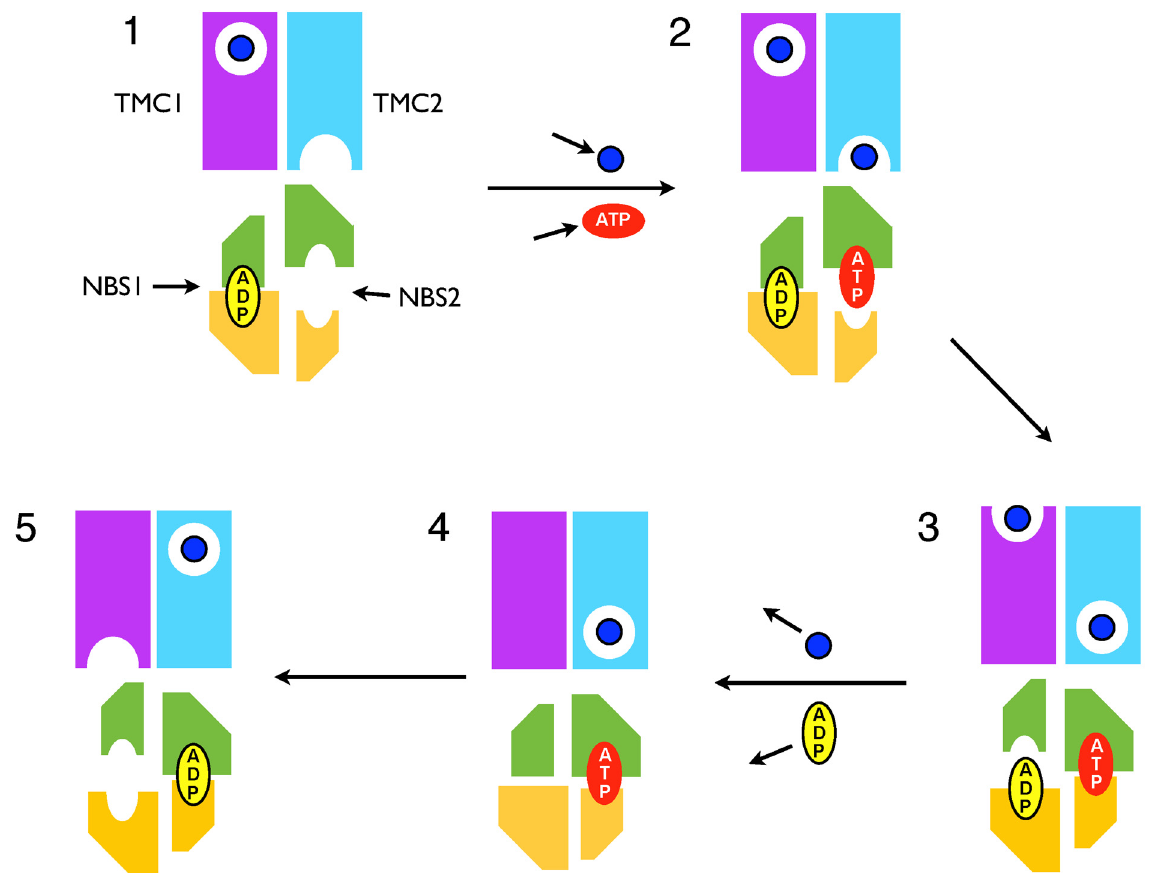
Figure 4. Reciprocating Model for an ABC Exporter. The translocation cycle of the full transporter involves two separate coupled ATP hydrolysis and substrate translocation cycles, which function 180 degrees out of phase (the cycle of a single TMC/NBS pair is depicted in Figure 3). One half cycle is shown in this figure. The TMD channels are depicted as magenta or cyan rectangles and referred to as TMCs 1 and 2, respectively. NBDs 1 and 2 are colored yellow and green, respectively. The substrate is depicted as a blue dot, ATP as a red lozenge, and ADP as a yellow lozenge. It is important to note that from a structural perspective, while the NBDs are depicted specifically, in con ‐ trast, the illustrated TMCs do not correspond to each TMD, rather the TMD dimer is imagined to embody two functionally distinct channels in a structurally unspecified way. The cycling scheme is as follows: ( 1 ) The exporter is poised to bind the substrate to the high affinity inward ‐ facing site of TMC2 and ATP to the open high affinity NBS2. Occluded transported substrate and ADP await dissociation from TMC1 and NBS1, respectively. ( 2 ) Substrate binds to TMC2 and ATP binds to NBS2. ( 3 ) Binding of substrate and ATP induces an isomerization of the transporter whereby NBS2 closes and occludes ATP, while ADP ‐ bound NBS1 opens. Coupled with this, the substrate bound to the inward ‐ facing site of TMC2 becomes occluded and the substrate is presented at the extracellular side of TMC1. ( 4 ) Following ADP release from NBS1 and substrate release from TMC1, the trans ‐ porter isomerizes to an occluded conformation in which empty NBS1 is closed. The transporter is now competent for ATP hydrolysis. This is close to the conformation captured by vanadate trap ‐ ping. ( 5 ) Upon ATP hydrolysis, the substrate is translocated to an occluded site on the extracellular side of TMC2, TMC1 opens a high affinity inward ‐ facing substrate binding site, and NBS1 opens to present a high affinity ATP binding site. This stage is equivalent to that depicted in Stage 1, which is for the opposite side of the cycle.